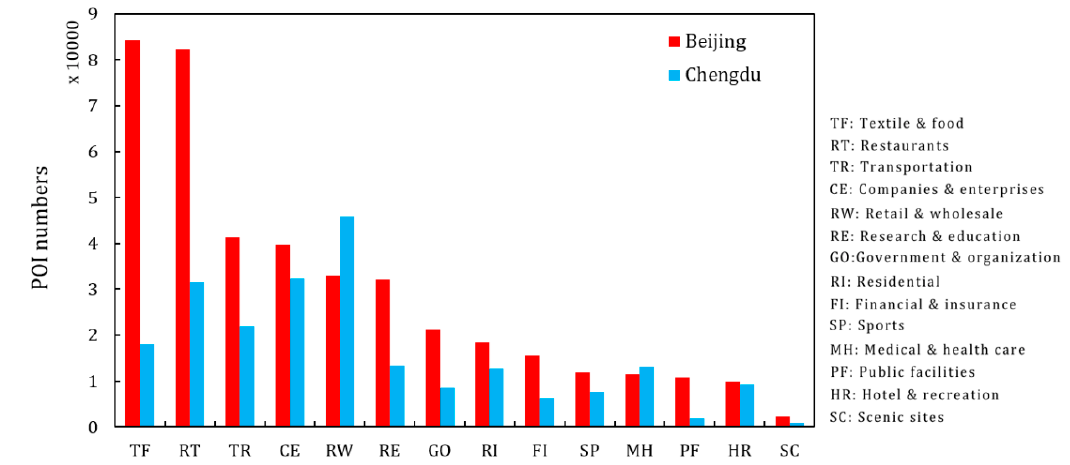
Figure 2. Number of points of interest (POIs) in each category of Beijing and Chengdu.